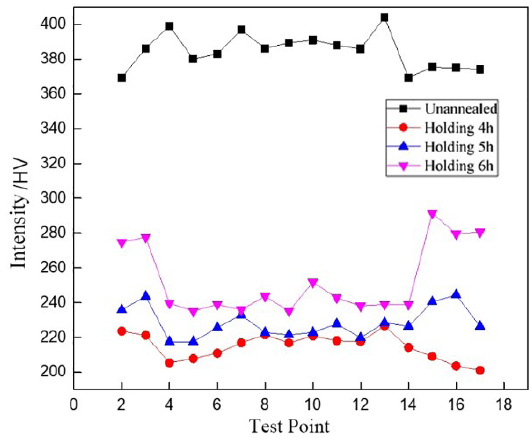
Figure 5. The curve of hardness distribution for SMAW welded joint.